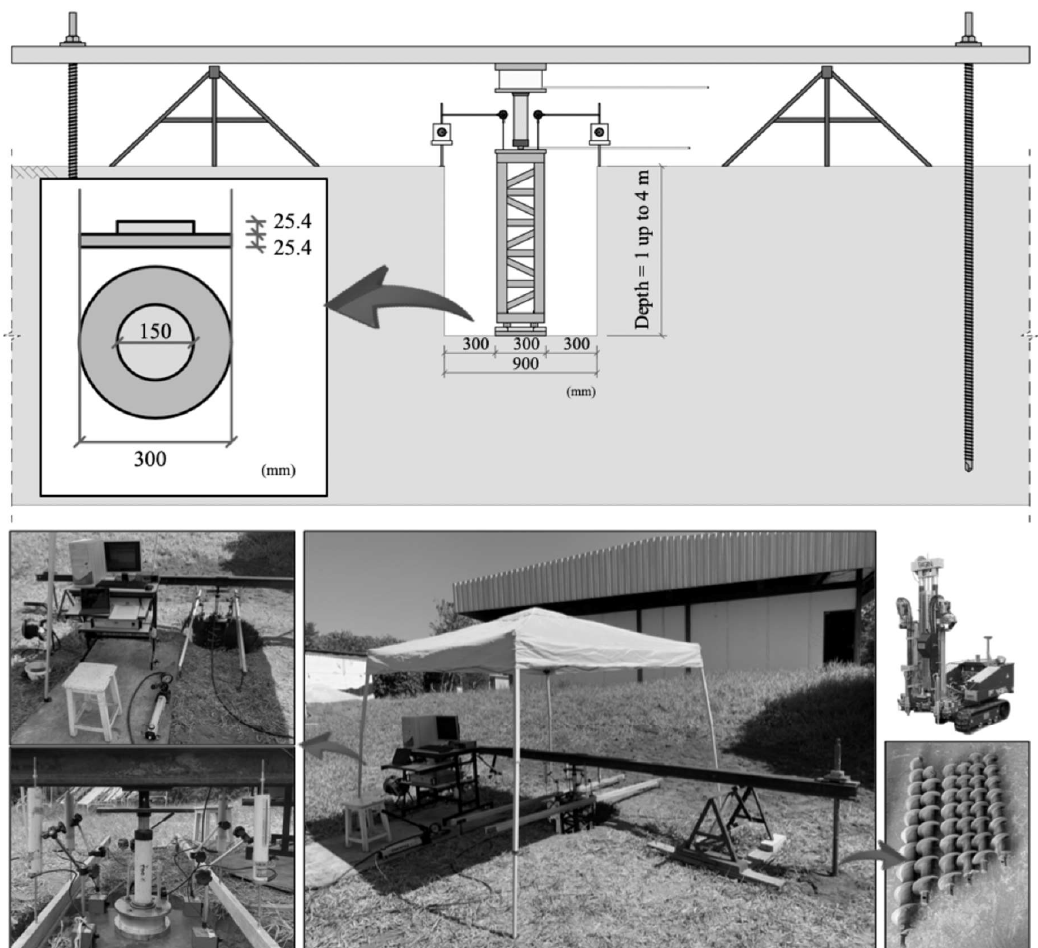
Figure 4. Equipment and setup for the plate load tests carried out at the site.